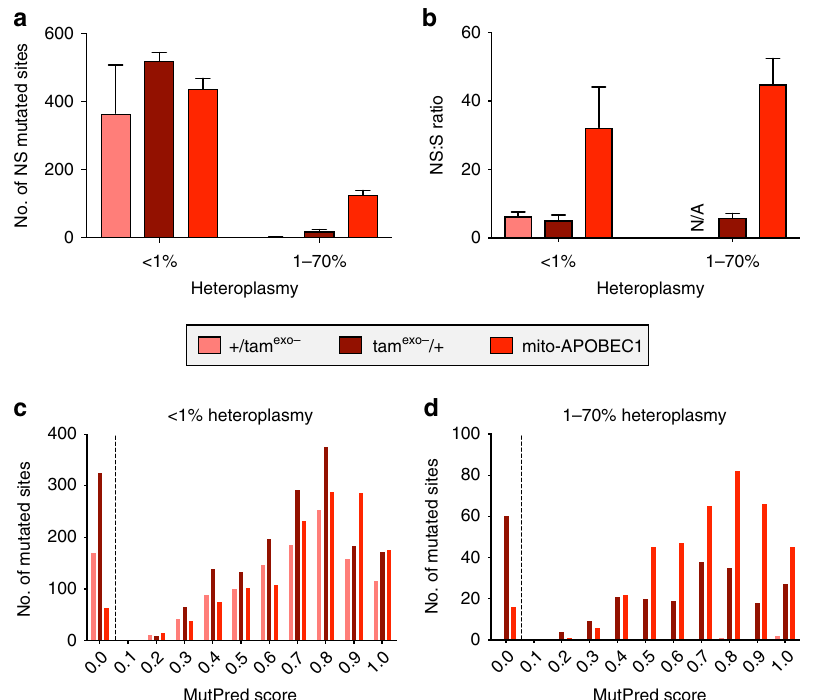
Fig. 7 mito-APOBEC1 causes high levels of non-synonymous pathogenic mutations. a Number of genomic sites presenting non-synonymous (NS) substitutions, at <1% or 1 – 70% heteroplasmy, in the indicated genotypes. b Non-synonymous:synonymous (NS:S) ratio of all substitutions recovered in protein-coding genes, separated by heteroplasmy level as previously indicated [Note: Only one non-synonymous substitution was found at >1% heteroplasmy in paternally inherited tam exo − and 0 synonymous mutations; therefore, the ratio is indicated as N/A]. Charts show mean ± SD, n = 3 animals. c , d Frequency distribution of MutPred scores, bin width = 0.05, for each mutation found in the indicated genotypes analysed by c <1% or d 1 – 70% heteroplasmy. ( n = 3 animals, data from each animal were sum by genotype). A dotted line separates the synonymous (MutPred score = 0) from non-synonymous mutations. Source data are provided as a Source Data fi